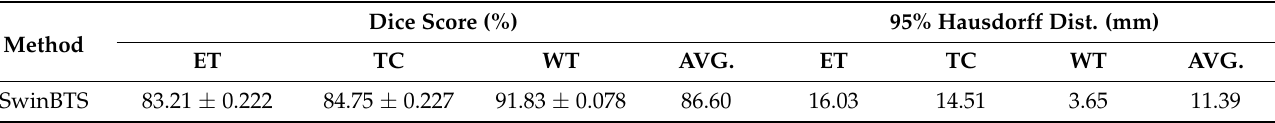
Table 4. Segmentation results on BraTS 2021 validation dataset.